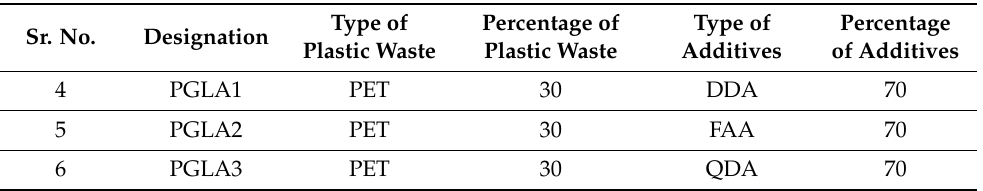
Table 4. Composition of developed plastic-based green lightweight aggregates.